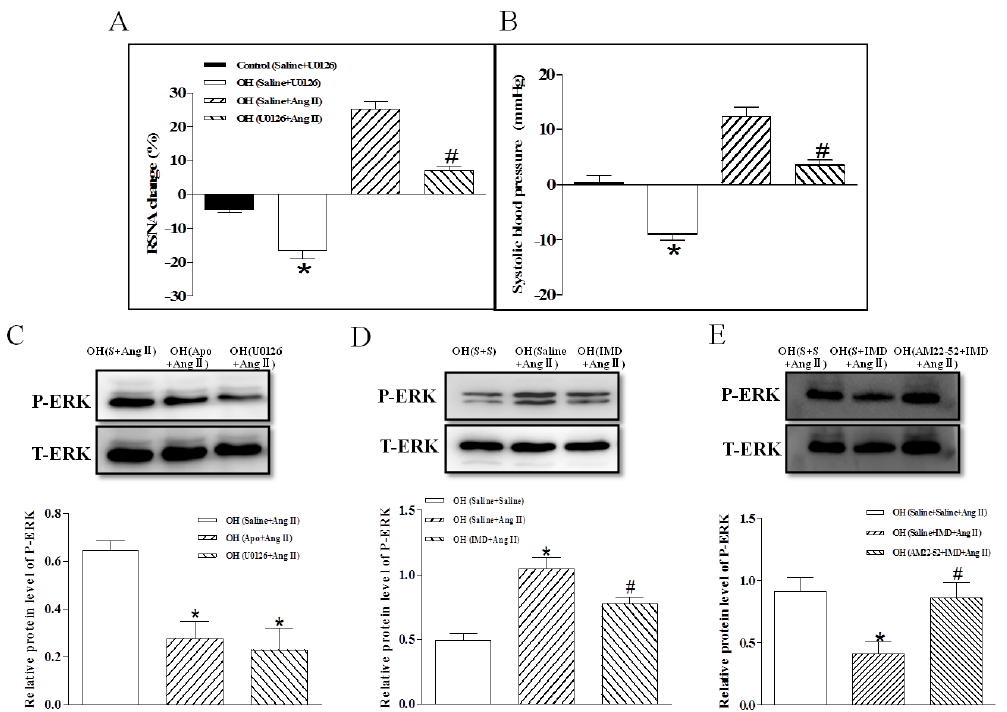
Figure 6. The effects of a PVN microinjection of ERK activation inhibitor U0126 on RSNA and MAP in control and OH rats; PVN U0126 pretreatment on Ang II—induced RSNA and MAP responses in OH rats; Apo, U0126 and IMD pretreatment on Ang II-induced ERK activation in OH rats; and AM receptor antagonist AM22-52 pretreatment on IMD responses to Ang II-induced ERK activation in OH rats. Values are mean ± SEM. * p < 0.05 versus control (saline + U0126); # p < 0.05 versus OH (saline + Ang II) ( A , B . n = 6 for each group). * p < 0.05 versus OH (saline + Ang II) ( C . n = 3 or 4 for each group). * p < 0.05 versus OH (saline + saline + Ang II), # p < 0.05 versus OH (saline + IMD + Ang II) ( D . n = 3 or 4 for each group). S: